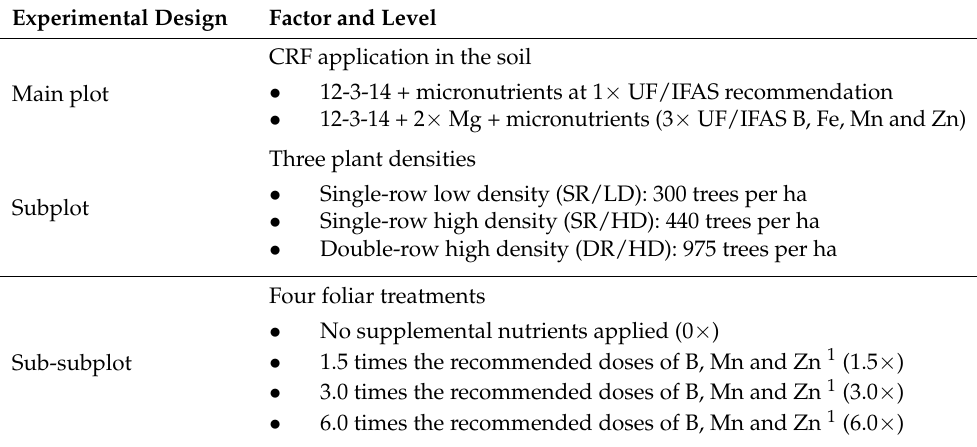
Table 10. Details about treatment factors and arrangements for experimental design.